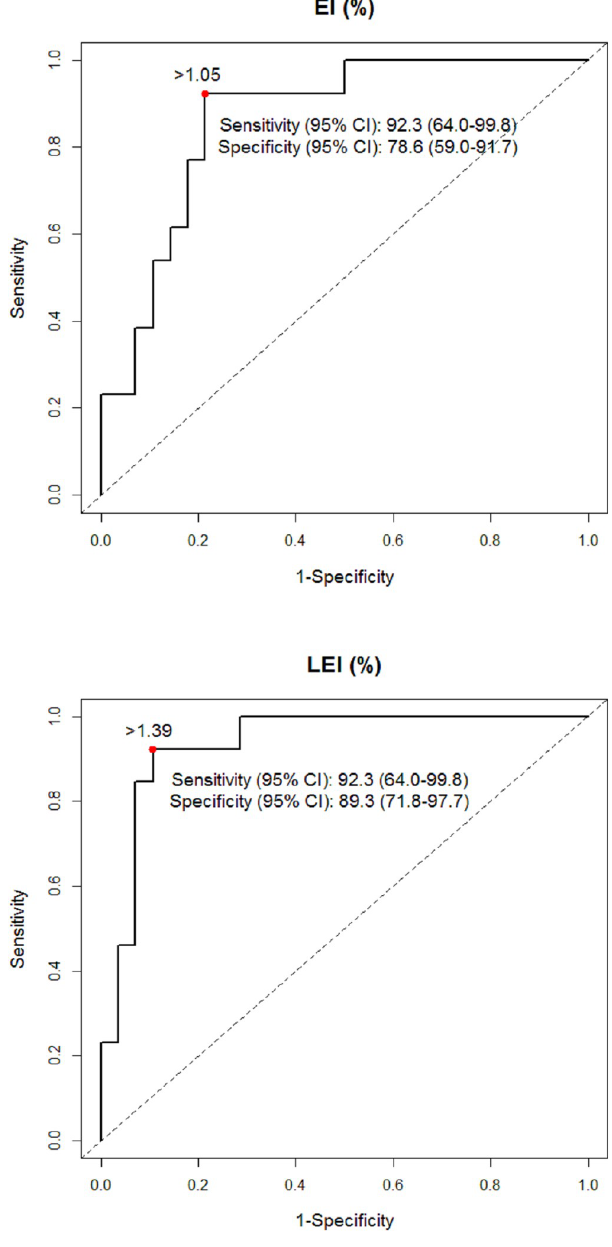
Fig 4. Youden index for determining the optional cutoff value for emphysema index (A) and lobe-specific emphysema index (B).